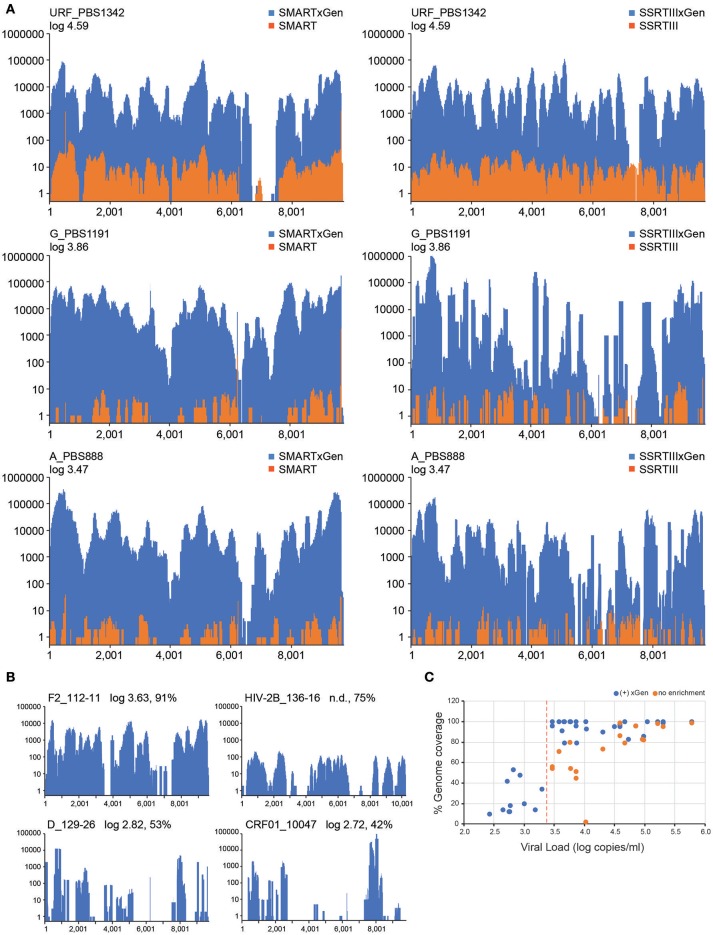
A HIV-xGen dramatically increases sensitivity for low titer specimens. (A) Coverage plots are shown for HIV-SMART libraries (top panels) without (orange) and with (blue) HIV-xGen as well as Superscript libraries without (orange) and with (blue) HIV-xGen. PBS1342 is a URF, PBS1191 is subtype G and PBS888 is subtype A. (B) Coverage plots for strains with titers ranging from log 2.7–3.6 copies/ml including a subtype F2 (112-11), a subtype D (129-26), a CRF01 (10047105267) and an HIV-2 strain (136-16) of unknown viral load. (C) Plot of viral load vs. genome coverage for all new strains sequenced with a known titer. Red dashed line = log 3.4 copies/ml; orange dots = no enrichment; blue dots = xGen enrichment.